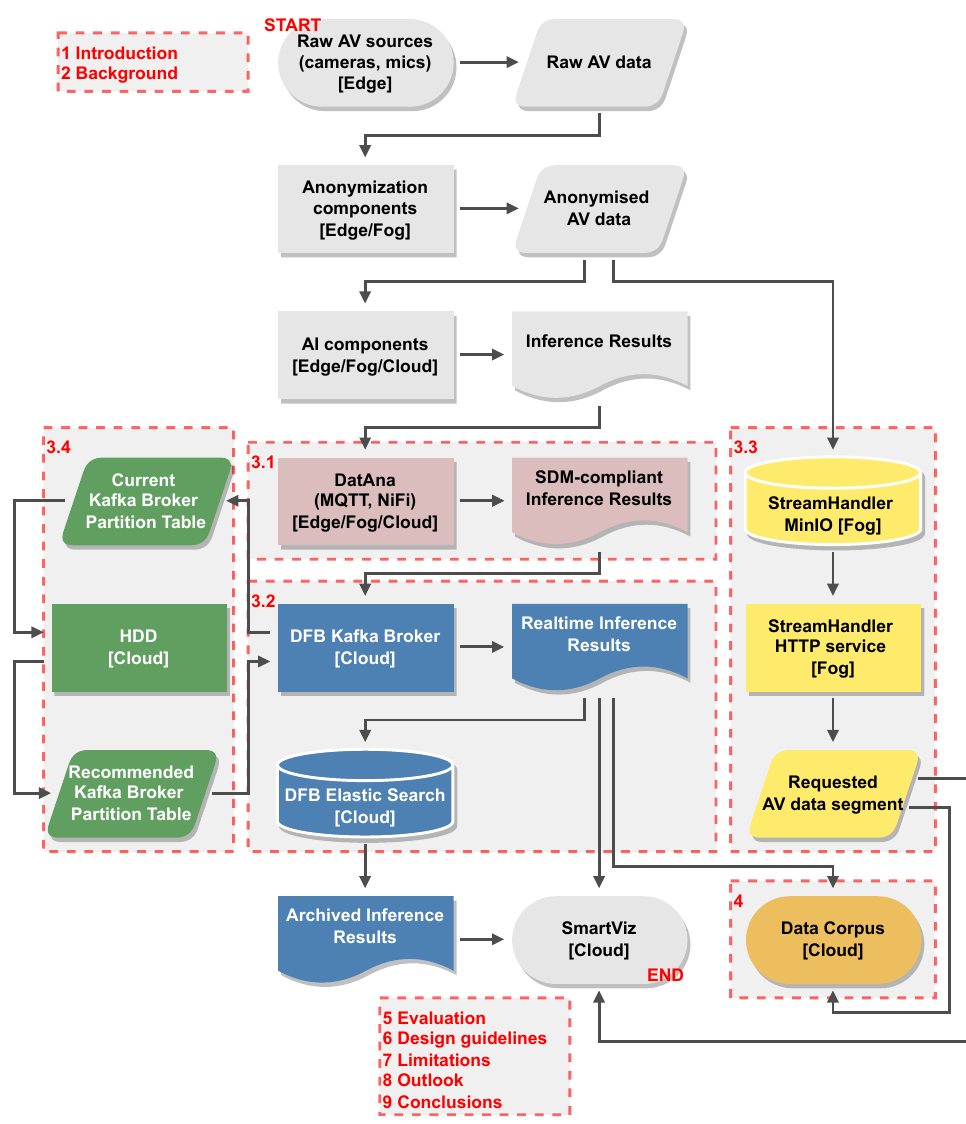
Figure 2. The flowchart of our